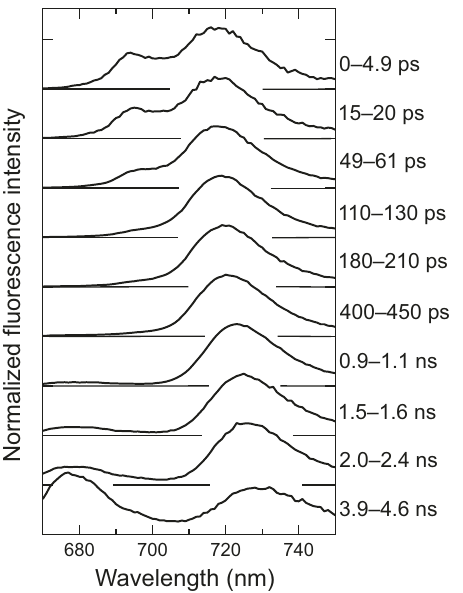
Fig. 6 TRF spectra of the Cyanophora PSI tetramer. The spectra were measured at 77 K with excitation at 445 nm, and were normalized by the maximum intensity of each